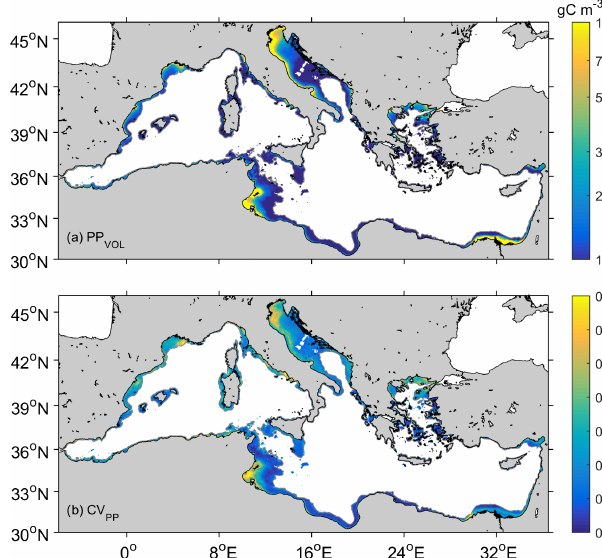
Figure 3. Mean distribution of (a) volumetric PP (PP VOL , in gCm − 3 ) and (b) coefficient of variation in volumetric PP values (CV PP